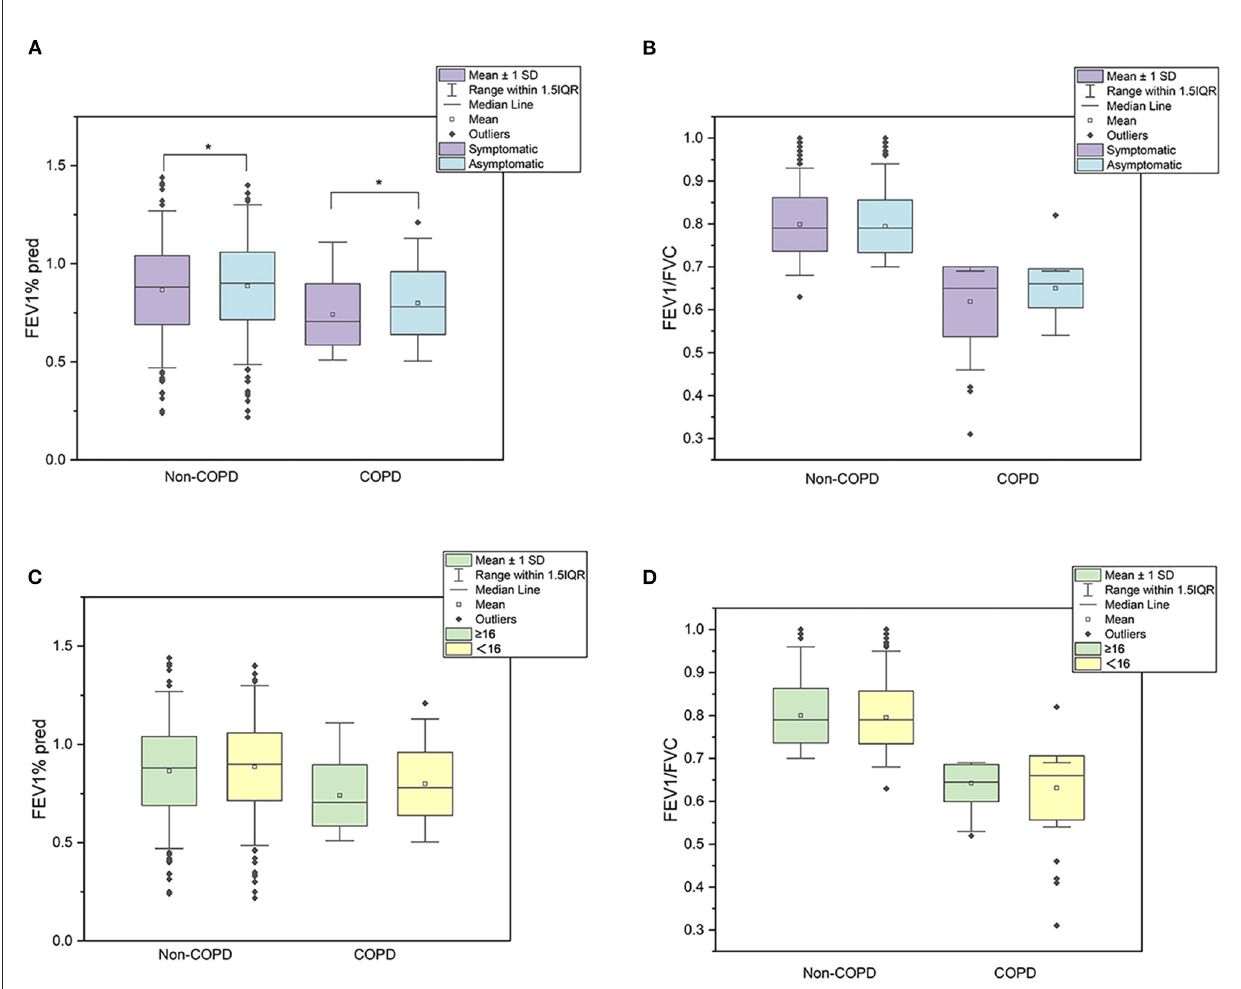
FIGURE2 Lung function in different groups. (A–D) presented the mean 1 SD and 1.5IQR of lung function. (A, B) aboutFEV 1 %pred and FEV1/FVC grouped by symptoms, respectively. (C, D) about FEV 1 %pred and FEV1/FVC grouped by screening questionnaire scores.